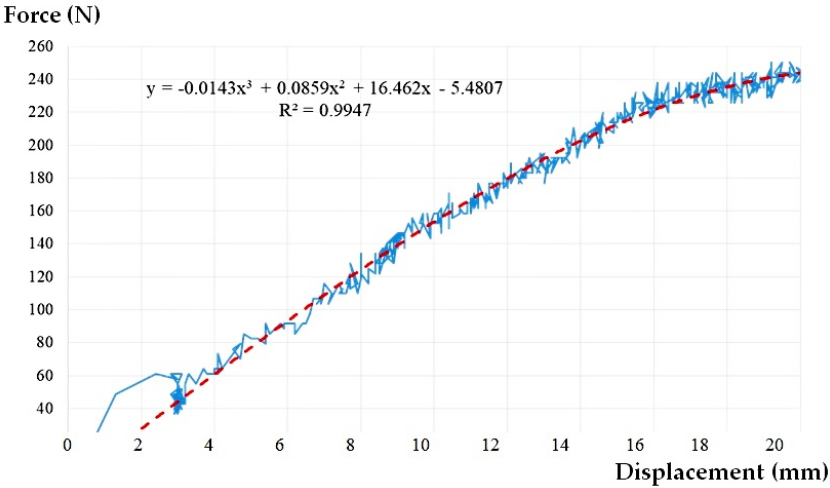
Figure 5. The graph load-displacement curve approximation and for CA500.